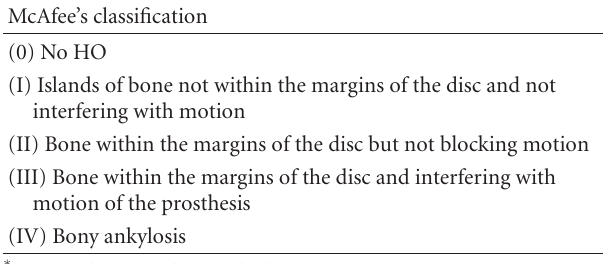
Table 1: McAfee’s classification of heterotopic ossification